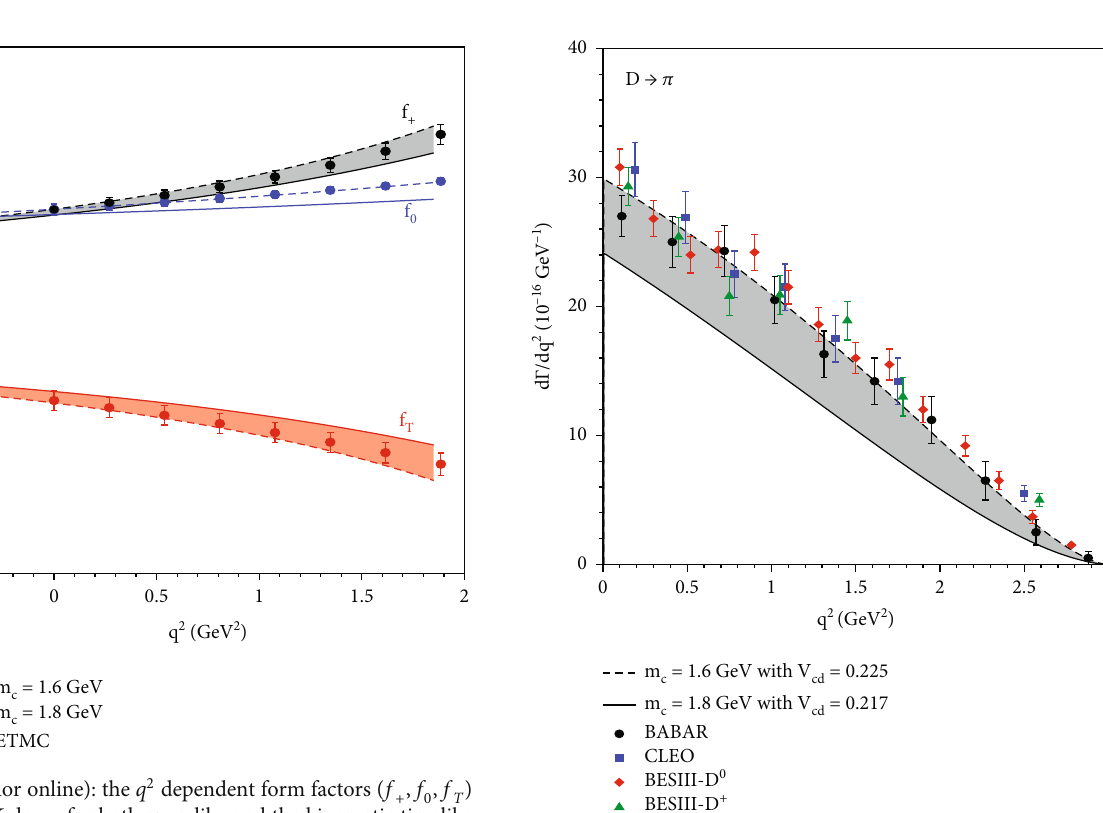
Figure 2: (Color online): the q 2 dependent form factors ( f of the D ⟶ K decay for both spacelike and the kinematic timelike − M Þ 2 GeV 2 . For comparison, the data regions, − 0 : 5 ≤ q 2 ≤ ð M D K taken from the LQCD (circles) [23, 24] are shown.